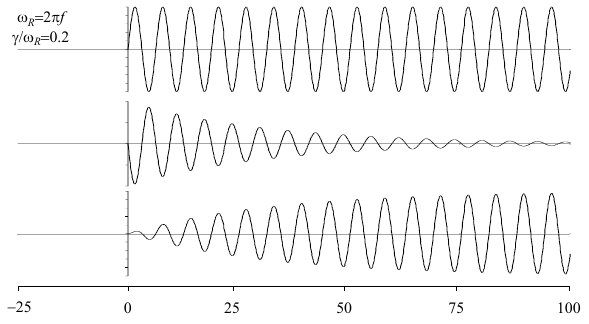
Fig. 11. Top panel: Directly driven reflected signal when ω R = 2 πf . Middle panel: Contribution from excited leaky waveguide mode. Bottom panel: Superposition.